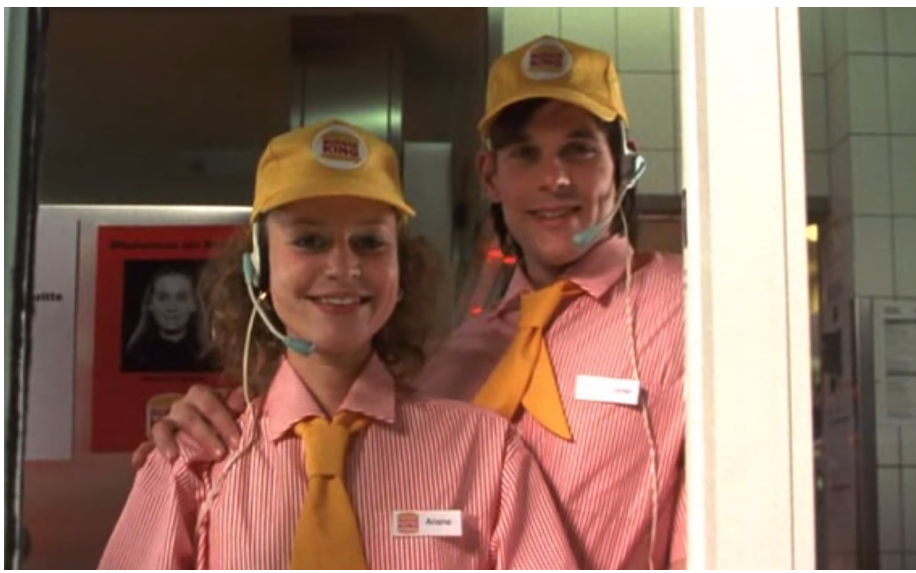
Figure 5 Ariane works at Burger King